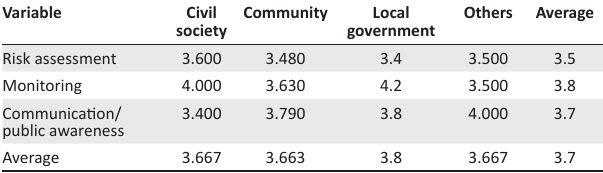
TABLE 2: Participants observation and reflection of risk. Variable